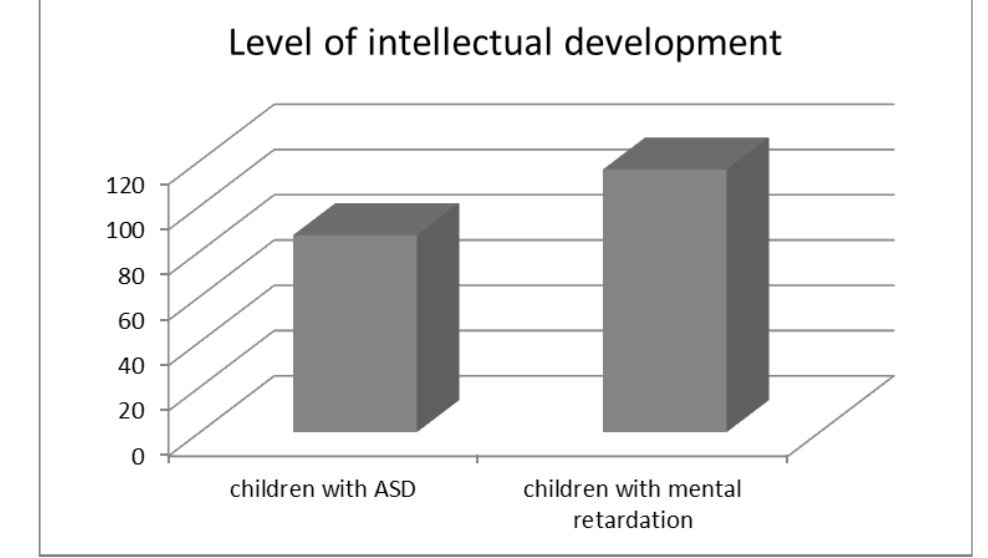
Fig.1. Difference between level of intellectual development of children with ASD and mental